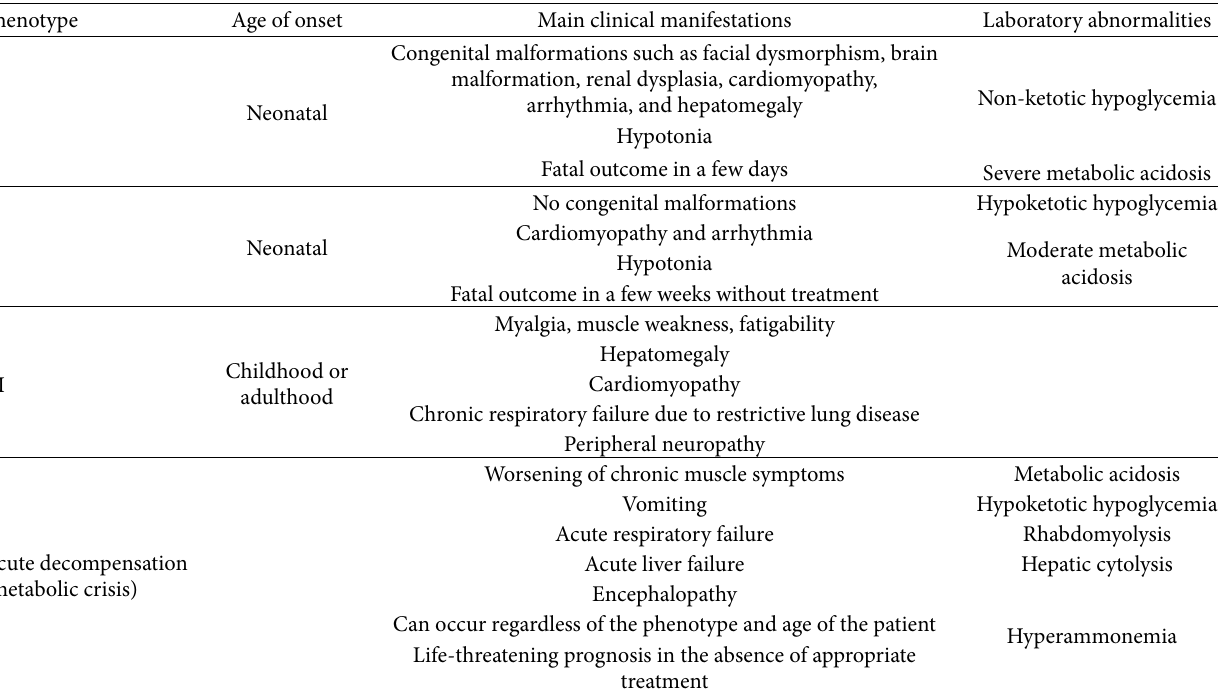
Figure 4: Simplified illustration of the mitochondrial respiratory chain. The respiratory chain is an electron transport chain that oxidizes reduced coenzymes (such as NADH) resulting from the degradation of organic compounds. It is composed of four protein complexes (I–IV) located in the inner mitochondrial membrane. The complexes are associated with two cofactors, coenzyme Q10 (Q) and cytochrome (C). This oxidation provides the energy required for proton transfer from the matrix to the mitochondrial intermembrane space. The resulting electrochemical gradient provides the energy needed for ATP synthase to phosphorylate ADP to ATP. The enzymes’ electron transfer flavoprotein (ETF) and ETF dehydrogenase (ETFDH) catalyze the transfer of electrons produced by fatty acid oxidation from acyl-coenzyme A dehydrogenase to coenzyme Q10, using flavin adenine dinucleotide (FAD) as a cofactor. Table 2: Description of the different phenotypes of